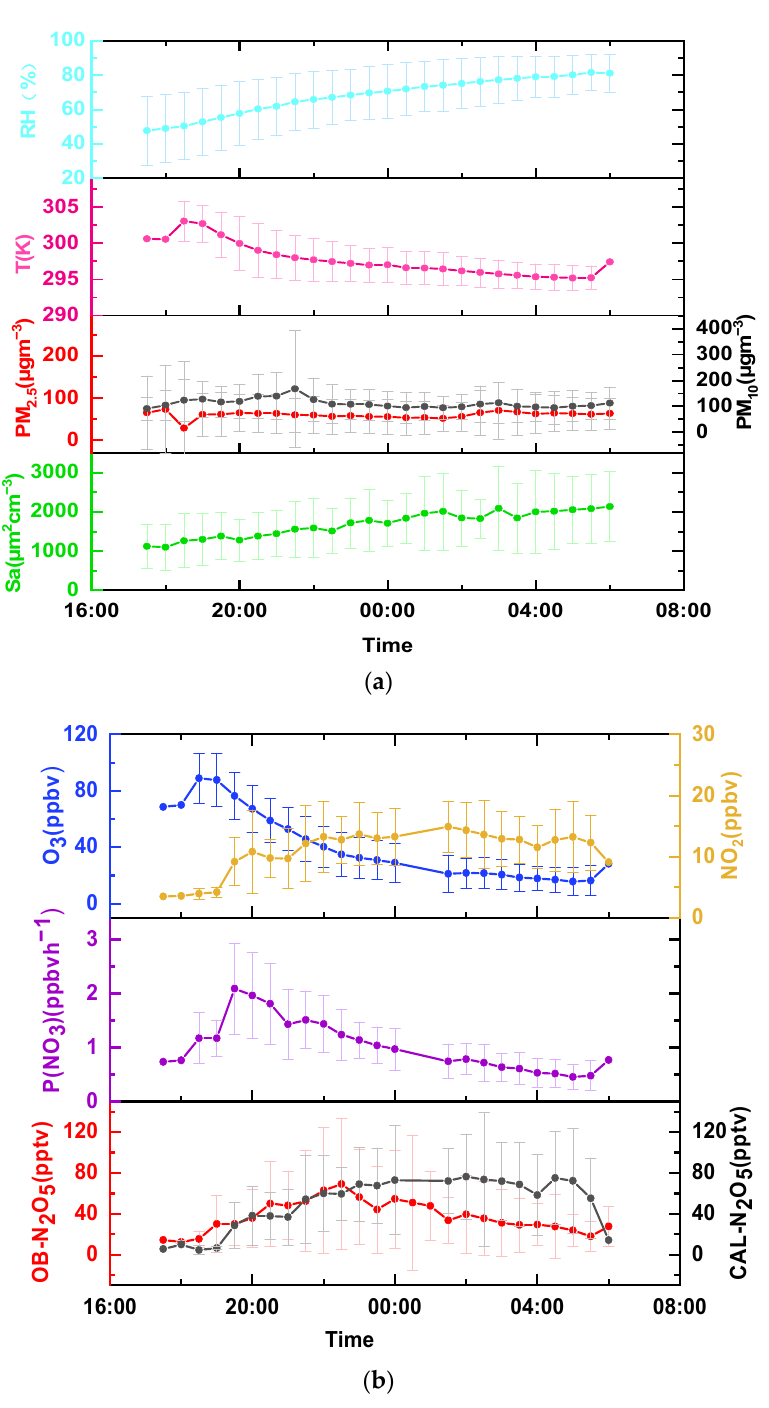
Figure 4. ( a ) Mean nocturnal profiles of temperature, humidity, PM 2.5 , PM 10 , and Sa in this campaign. ( b ) Mean nocturnal profiles of NO 2 , O 3 , N 2 O 5 , and P(NO 3 ) during the measurement period; the error bar is the standard deviation. OB N 2 O 5 is the mixing ratio of N 2 O 5 observed by CIMS, and CAL N 2 O 5 is the mixing ratio of N 2 O 5 calculated by NO 3 and NO 2 . During the measurement period, the mean nocturnal variations of the calculated N 2 O 5 and observed N 2 O 5 showed the same trend and their concentrations were basically consistent before midnight, with the large discrepancy shown after midnight. After midnight, the humidity was above 70 percent, which accelerated the heterogeneous hydrolysis of N 2 O 5 . The discrepancy between the calculated N 2 O 5 and observed N 2 O 5 was mainly ascribed to the heterogonous uptake of N 2 O 5 . The observed N 2 O 5 concentration